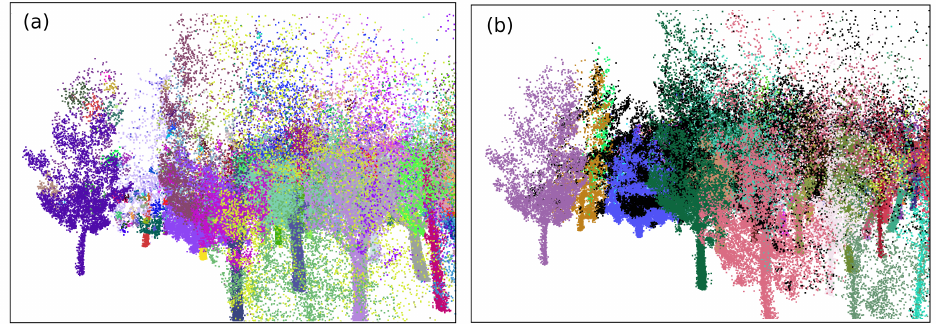
Figure 10. Screenshots of the point cloud at this stage. ( a ) The whole set of points are classified into floating and ground-connected clusters. ( b ) All segments are merged, following the logic explained in this work (black points represent all the points that are discarded during the cylinder voxelization and will be correctly assigned to each segment in the last